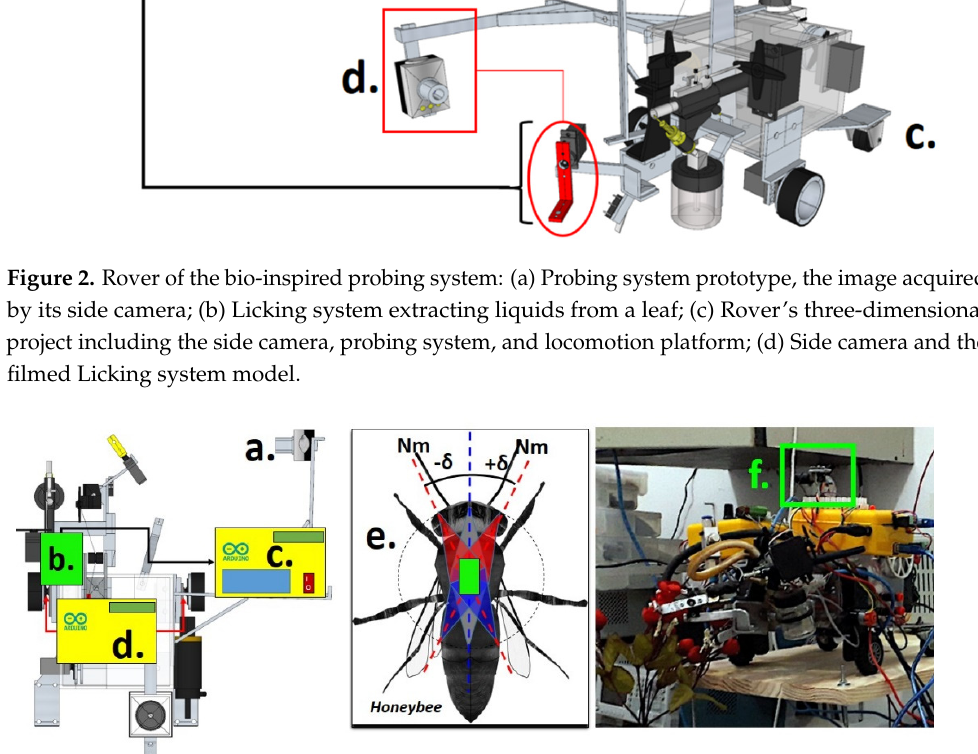
Figure 2. Rover of the bio-inspired probing system: ( a ) Probing system prototype, the image acquired by its side camera; ( b ) Licking system extracting liquids from a leaf; ( c ) Rover’s three- dimensional project including the side camera, probing system, and locomotion platform; ( d ) Side camera and the filmed Licking system model.